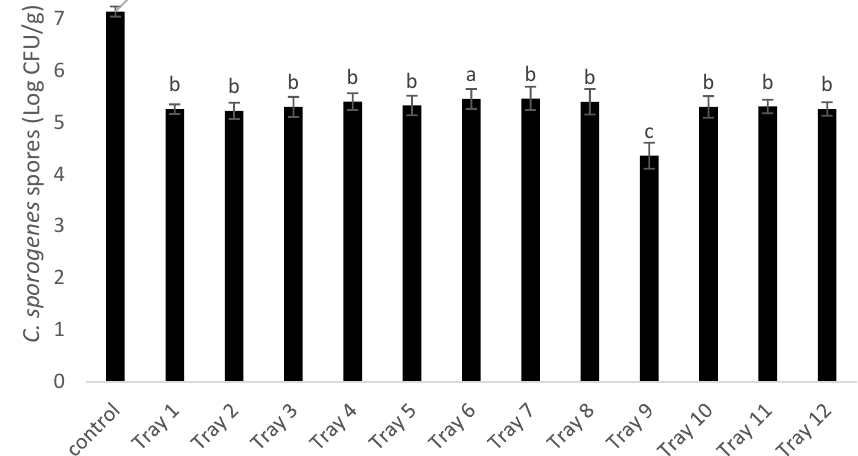
Figure 6. Loci for inoculation for spore pouches ( C. sporogenes ), where the set up represents a carrier tray with 12 packaging trays and the black squares shows the cold spot for pouch inoculation(a) C. sporogenes spores surviving post CiMPAS processing in pouches inoculated at the coldest spot on each tray after processing through R-65. Each bar represents the average e ± standard deviation ( n = 9) including three technical and three processing replicates. Note: Similar letters among the bars indicate no significant difference ( p > 0.05)